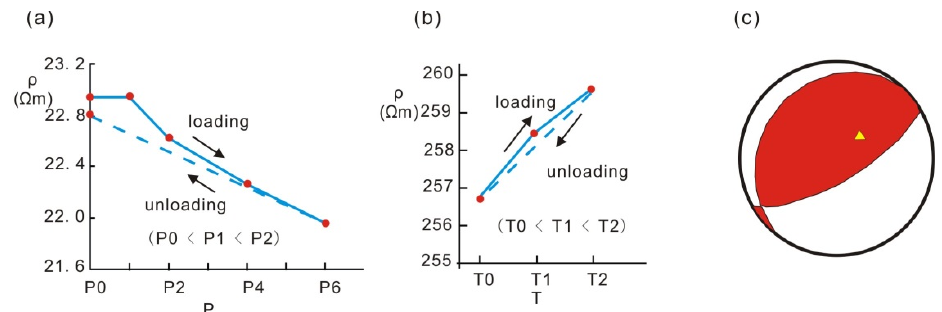
Figure 5. Plots of the ( a ) resistivity variations with pressure loading (compression) and unloading (dilatancy) and ( b ) resistivity variations with tension loading (dilatancy) and unloading (compres- sion) [14,49]. And ( c ) focal sphere of the Jiashi Mw 6.0 earthquake on 19 January 2020. The yellow triangle indicates the location of the Kalpin Apparent Resistivity Observatory.